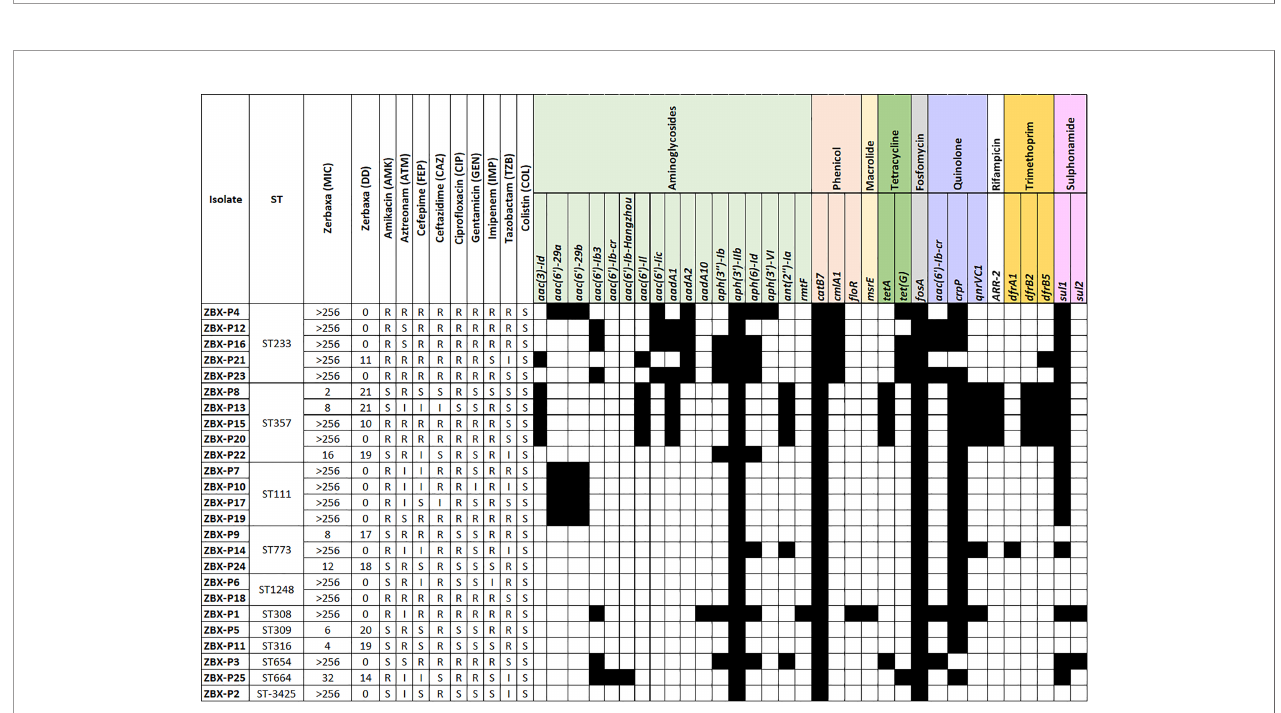
FIGURE 2 | PFGE dendrogram and Serotype in the C/T P. aeruginosa isolates. Dendogram was generated by BioNumerics software version 7.6.1 showing the relationship of the isolates based on their banding patterns generated by SpeI restriction digestion. Isolates ’ STs, and pulsotypes (PT) are shown.